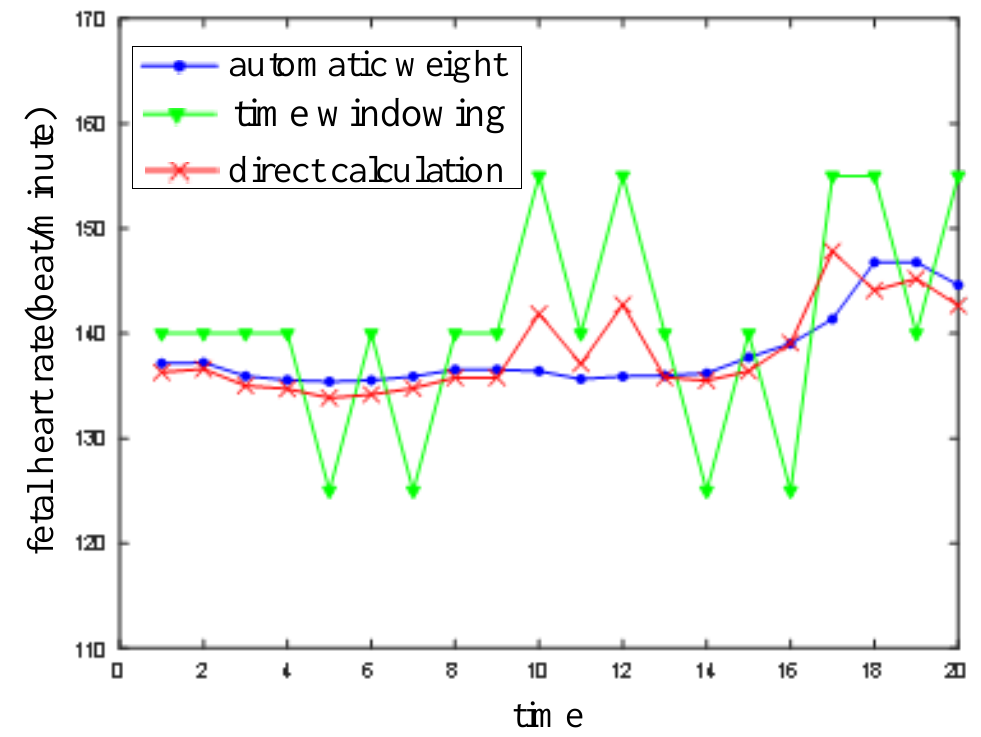
Figure 7. Comparison of three fetal heart rate extraction algorithms.